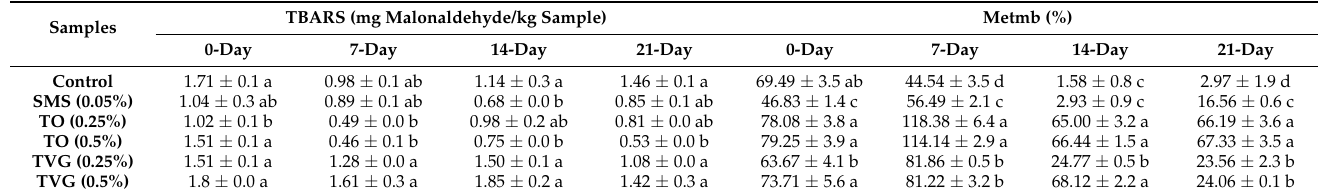
Table 4. TBARS and Metmb (%) values of vacuum-packed beef mince treated with TO and TVG during refrigerated